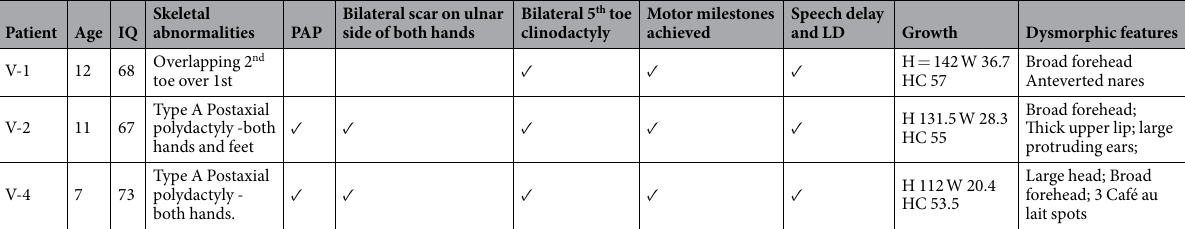
Table 1. Clinical summary. The clinical data for the three affected children is summarised. H = height in cm; W = weight in kg; HC = head circumference in